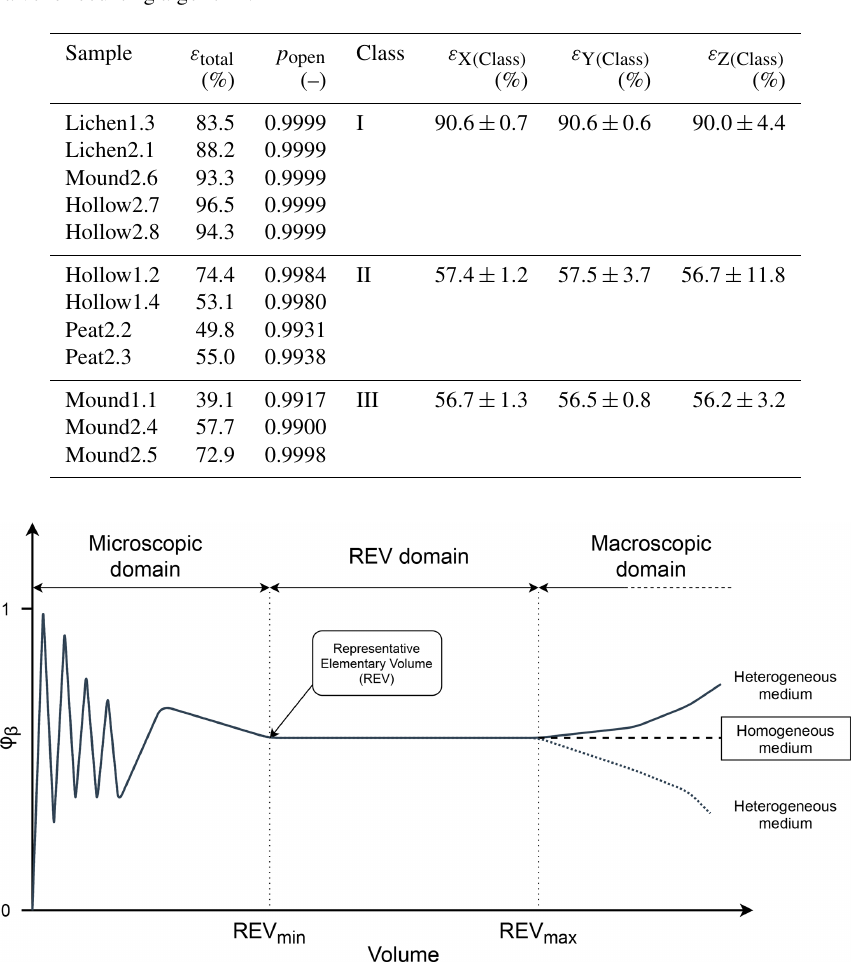
Table 3. Computed global porosity ( ε total ), ratio of open porosity ( p open ), classification (I, II, II) and average planar porosity (%) for each sample obtained using a voxel-counting algorithm.